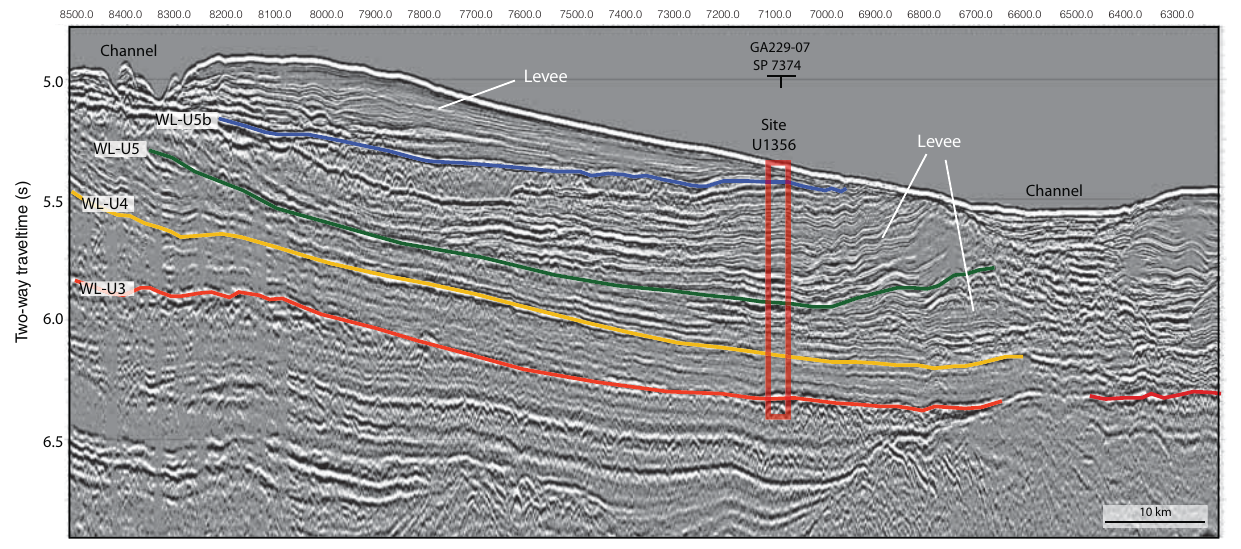
Figure 7. Multichannel seismic reflection profile across Site U1356 showing regional unconformities WL-U3, WL-U4, and WL-U5. Red rectangle = approximate penetration achieved at Site